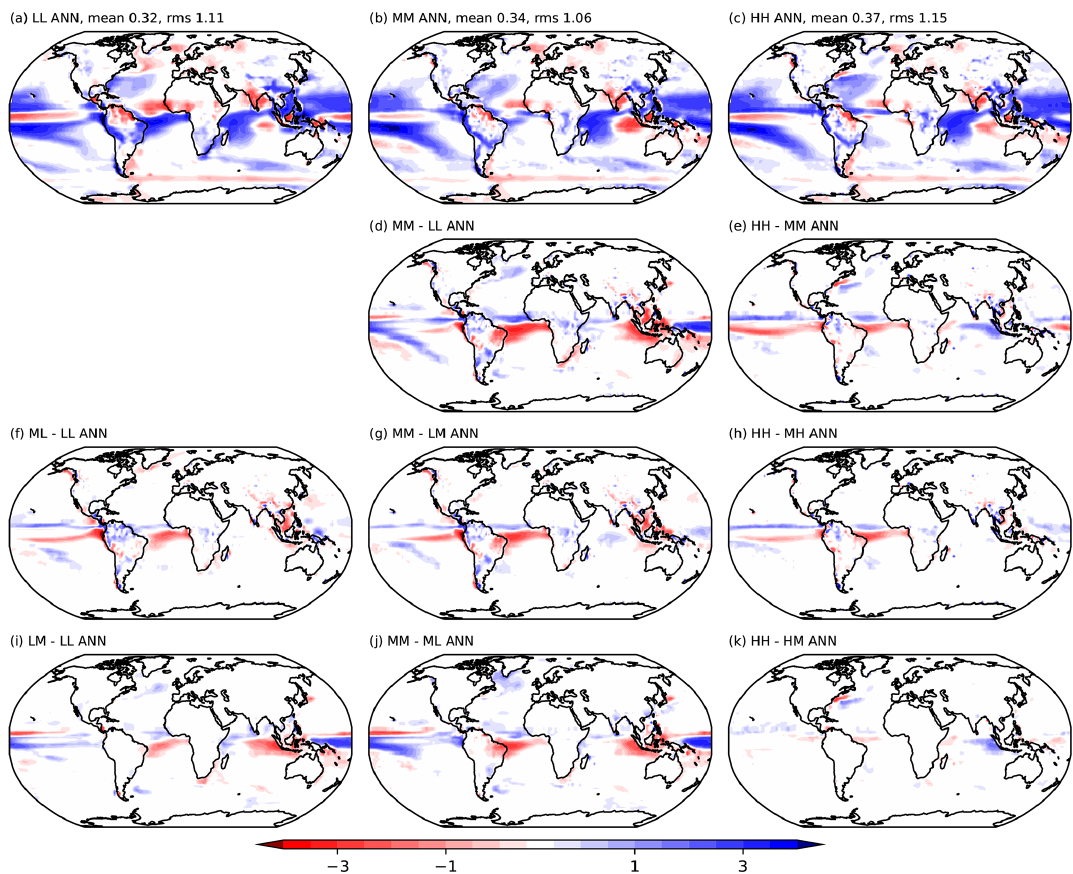
Figure 13. Top row: annual mean model precipitation bias of control-1950 model years 50–100 vs. GPCP_v2.3 1979-2014; second row: the total precipitation differences between MM-LL and HH-MM resolutions; third row: the impact of changing the atmosphere resolution at each reference ocean resolution; bottom row: the impact of changing the ocean resolution at each reference atmosphere resolution. Units are mmd − 1